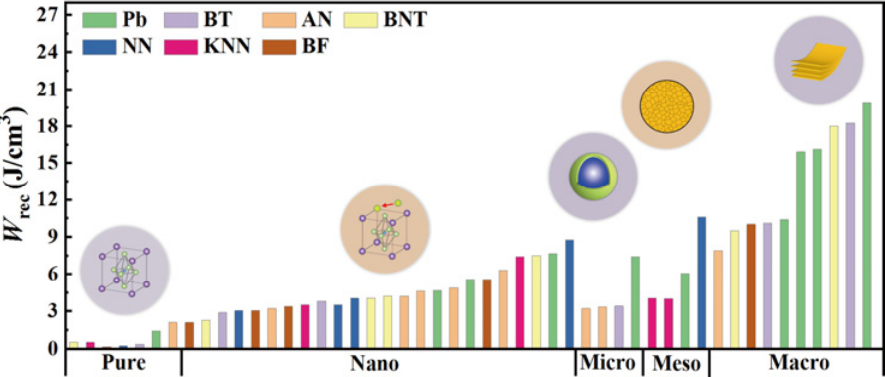
Fig. 25 W rec of energy storage ceramics after modification by different